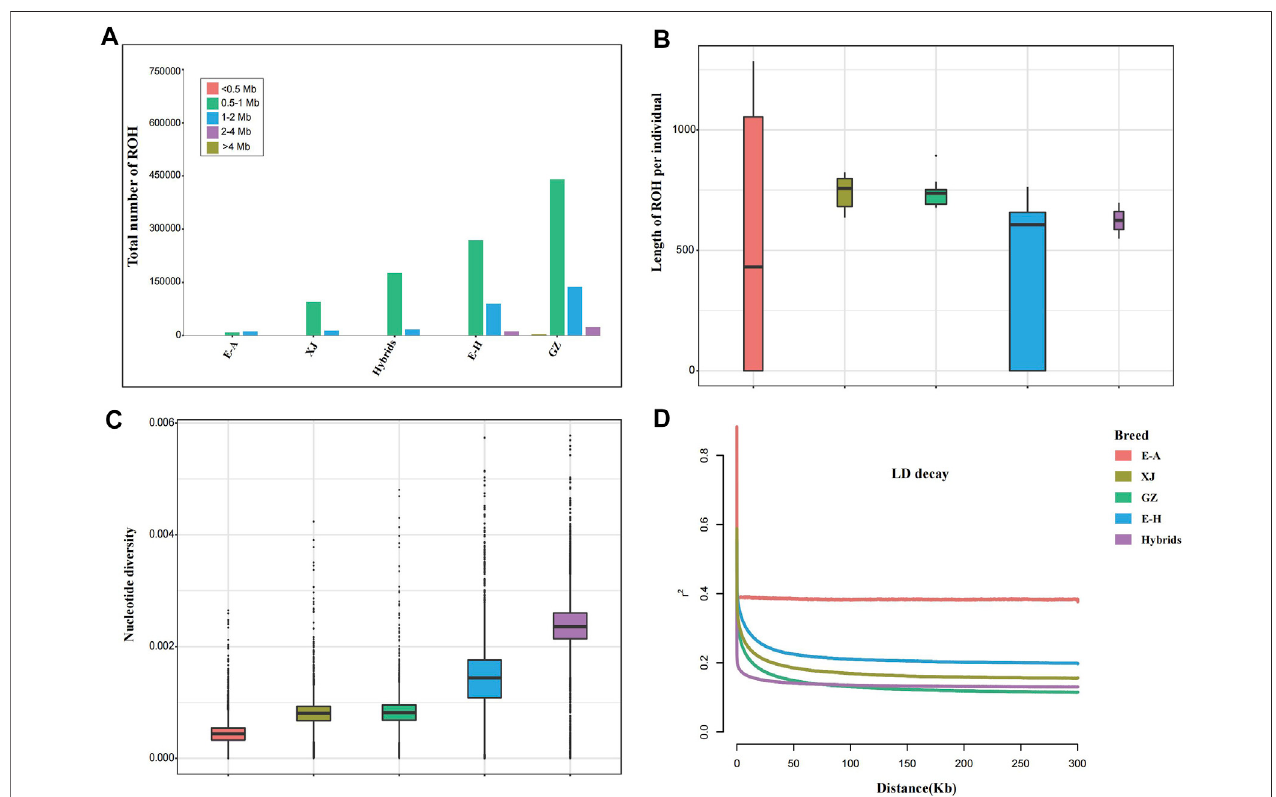
FIGURE 2 | Summary statistics for genomic variation. (A) The distribution of the total number of ROHs across chromosomes. (B) The distribution of lengths of ROHs in each breed. (C) Genome-wide distribution of nucleotide diversity of each breed in 50 kb windows with 50 kb steps. The horizontal line inside the box indicates the median of this distribution; box limits indicate the fi rst and third quartiles; and points show outliers. Data points outside the whiskers can be considered outliers. (D) Genome-wide average LD decay estimated from each